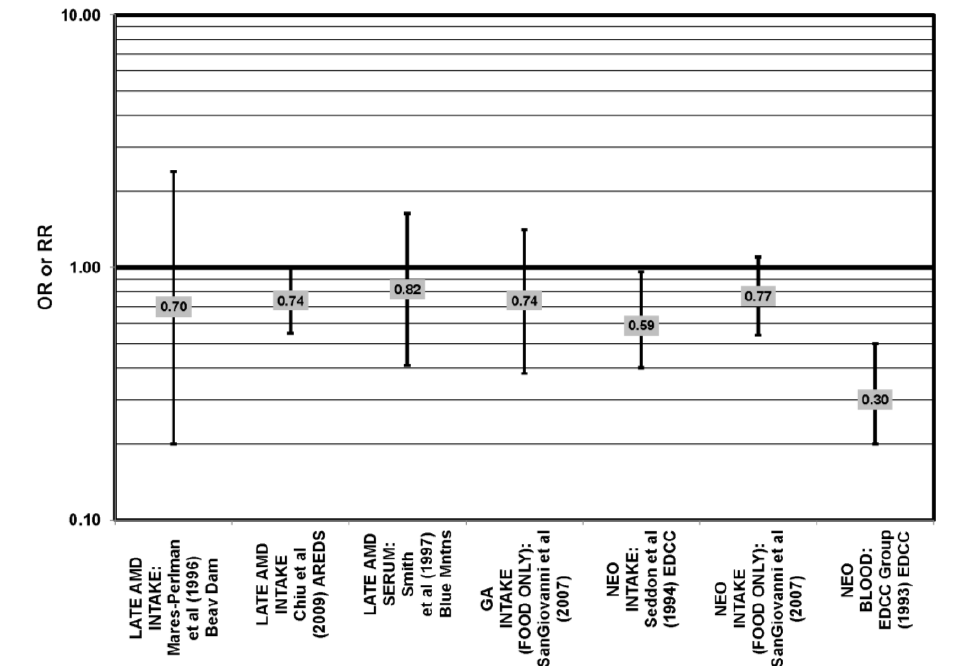
Figure 33. Odds or risk ratio for late AMD, severe AMD, geographic atrophy (GA), exudative AMD (EXUD) or neovascular AMD (NEO); high vs. low intake or blood levels of beta-carotene: retrospective and cross-sectional